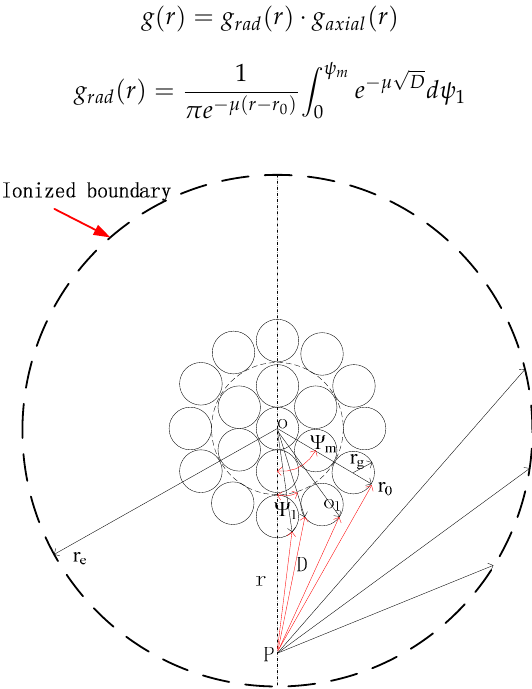
10 of 14 Table 7. Computation error: change in electric field with number of charges on a single strand. Number of Charges on a Single Strand ( n 2 )